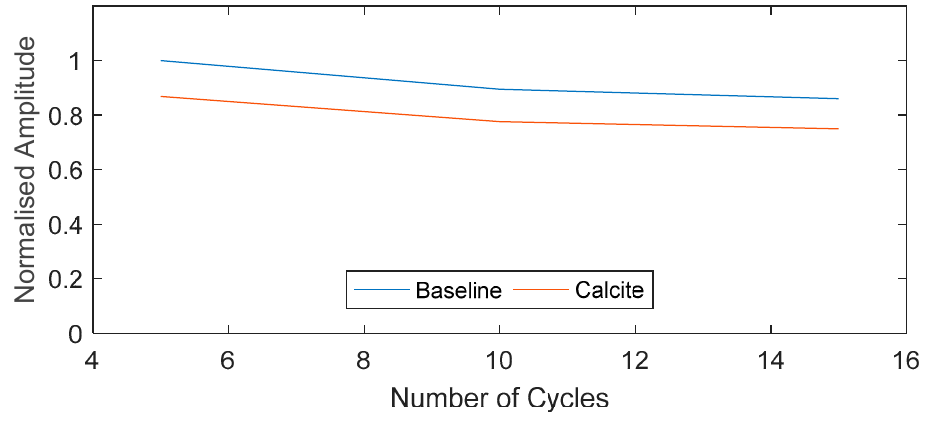
Figure 7. Experimental results—Comparison of maximum amplitude for baseline and Calcite signal at different number of signal cycles.